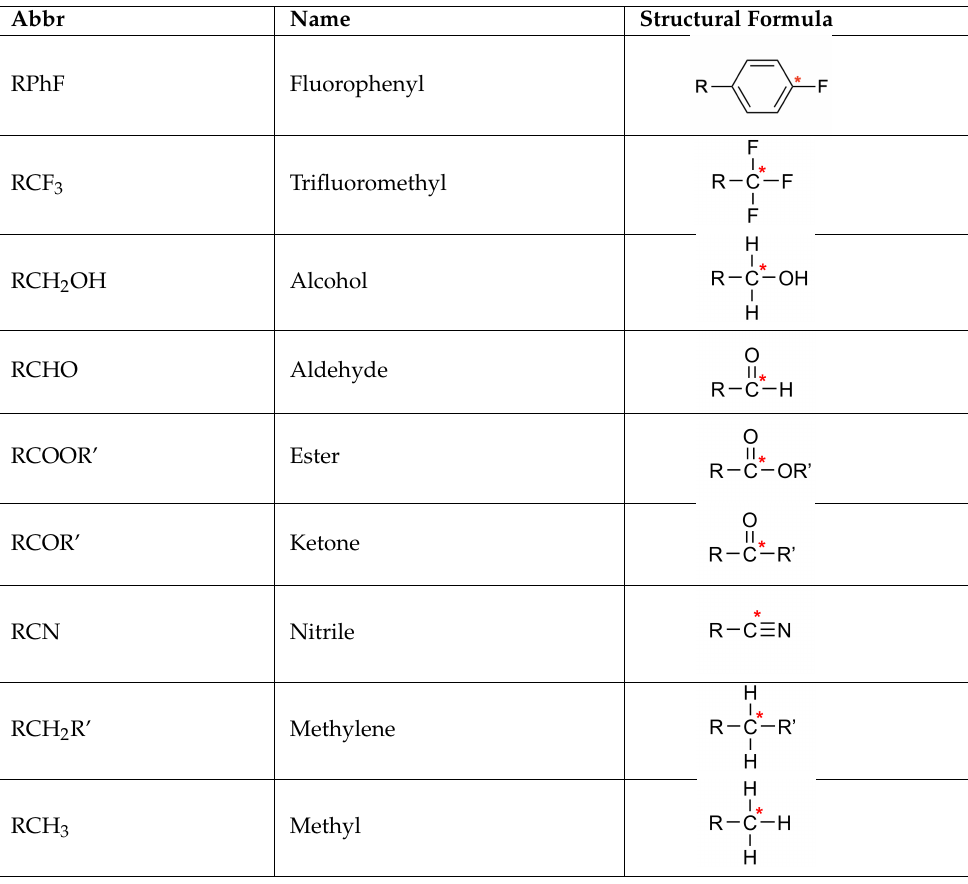
Figure A1. 3D visualization of motifs and the functional groups they represent. Table A4. The first column lists the structural abbreviations corresponding to the legends in Figure 6. The second column lists the corresponding chemical groups. The first column shows the structure